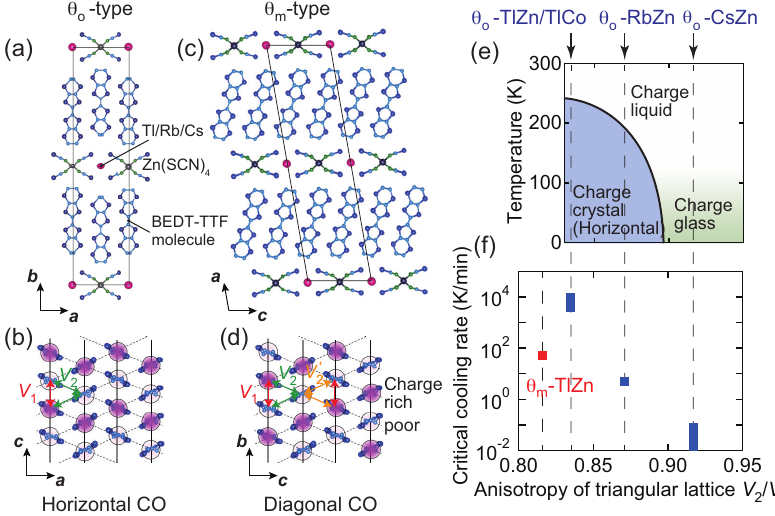
Figure 1. Crystal structure and phase diagram of θ –type (BEDT–TTF) salts. ( a ) Crystal structure of the θ o -type salts viewed along the c -axis direction. The rectangle indicates the unit cell. ( b ) 2D conducting BEDT-TTF layers within the a - c plane for the θ o -type salts. ( c ) Crystal structure of the θ m -type system viewed along the b -axis direction. The parallelogram indicates the unit cell. ( d ) 2D conducting BEDT-TTF layers within the b - c plane for the θ m -type system. ( e ) Phase diagram of the θ o -type system a function of the anisotropy parameter, V 2 / V 1 . ( f ) Critical cooling rate for charge-glass formation for various θ -type salts as a function of V 2 / V 1